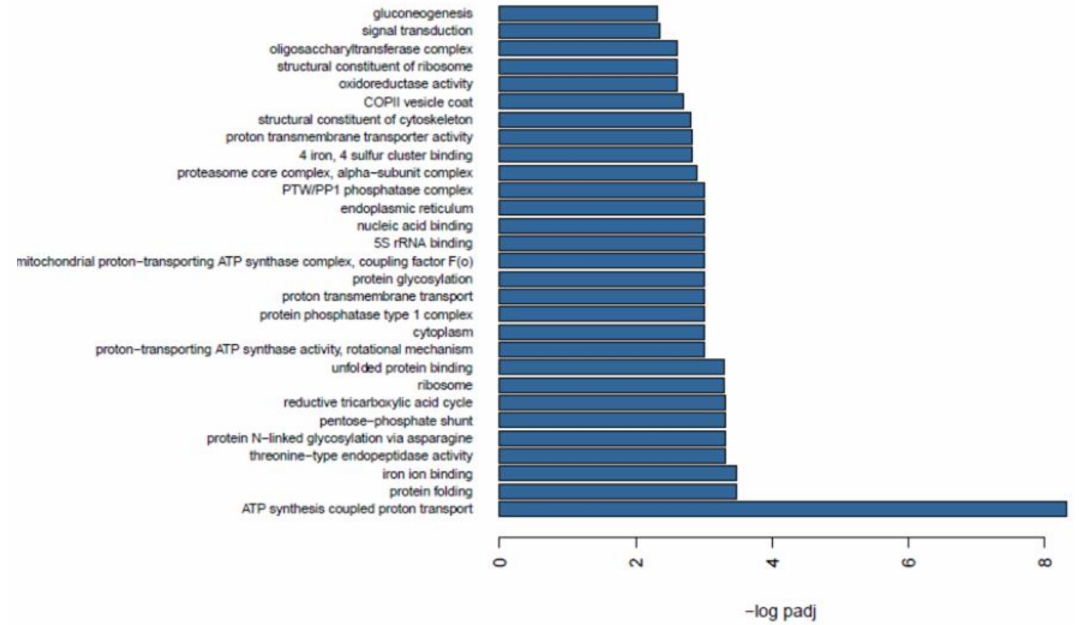
Figure 6. Gene Ontology (GO) analysis of sea cucumber differentially expressed genes modulated in farmed animals.